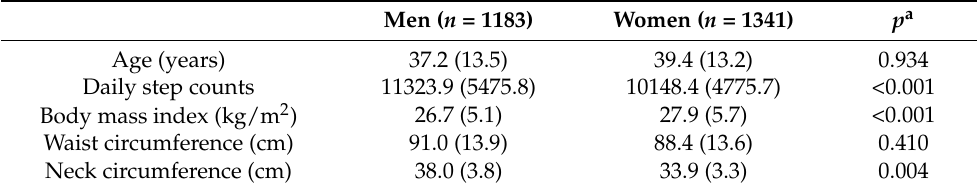
Table 2. Descriptive characteristics of participants stratified by